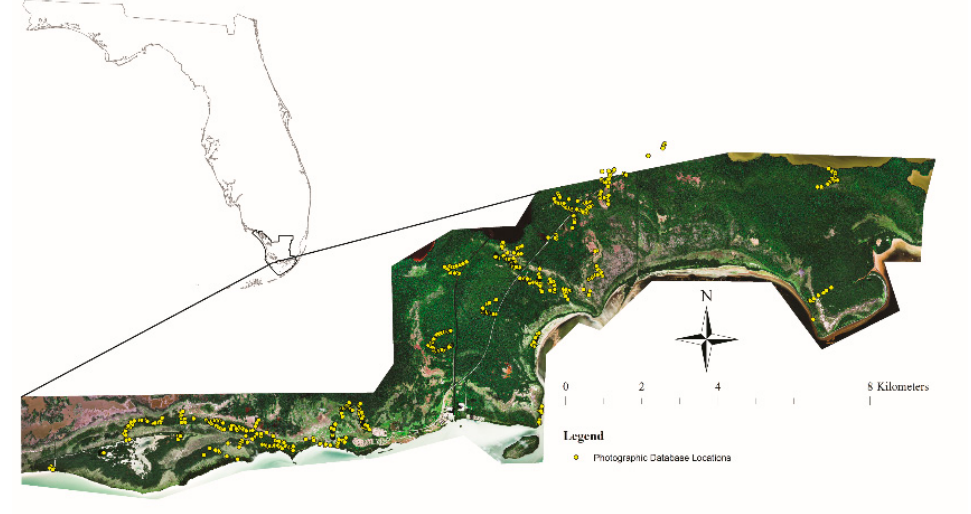
Figure 1. DigitalGlobe WorldView-2 satellite image (red, green, blue bands displayed in RGB) of 71 km 2 study site along the south Florida coast around Flamingo, Everglades National Park (ENP) with Florida Bay to the south. The inset shows Florida with ENP outlined and location of the study area indicated. The ENP road to Flamingo is visible, running NE to SW through the center of the image. Mapped yellow points are the GPS points associated with the 2012–2015 photographic database of the study area.